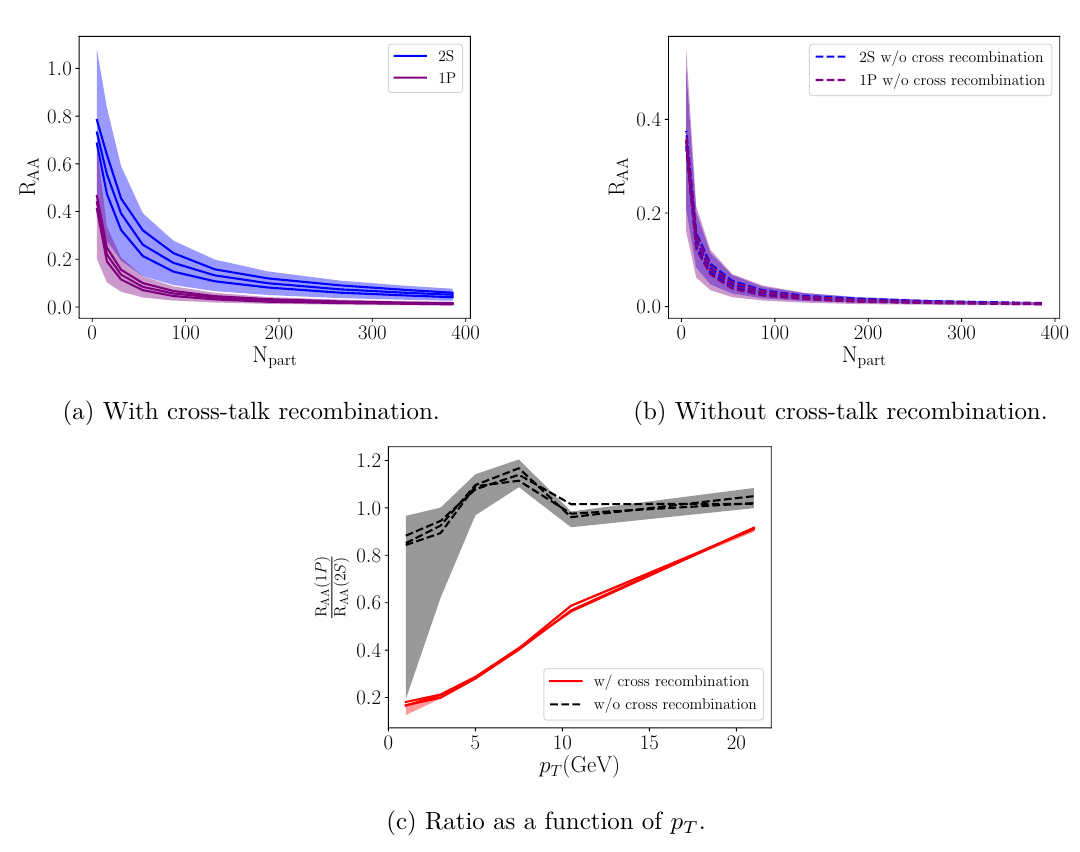
Figure 7. R AA ( χ b (1 P )) compared with R AA (Υ(2 S )) from calculations with and without cross- talk recombination. The R AA ’s as functions of centrality are shown in the first row. The ratio of R AA ( χ b (1 P )) and R AA (Υ(2 S )) as a function of p T is shown in the second row. Different curves correspond to difference choices of parameters and the band indicates the nPDF uncertainty. The double ratio observable has huge discriminatory power to distinguish calculations with and without correlated